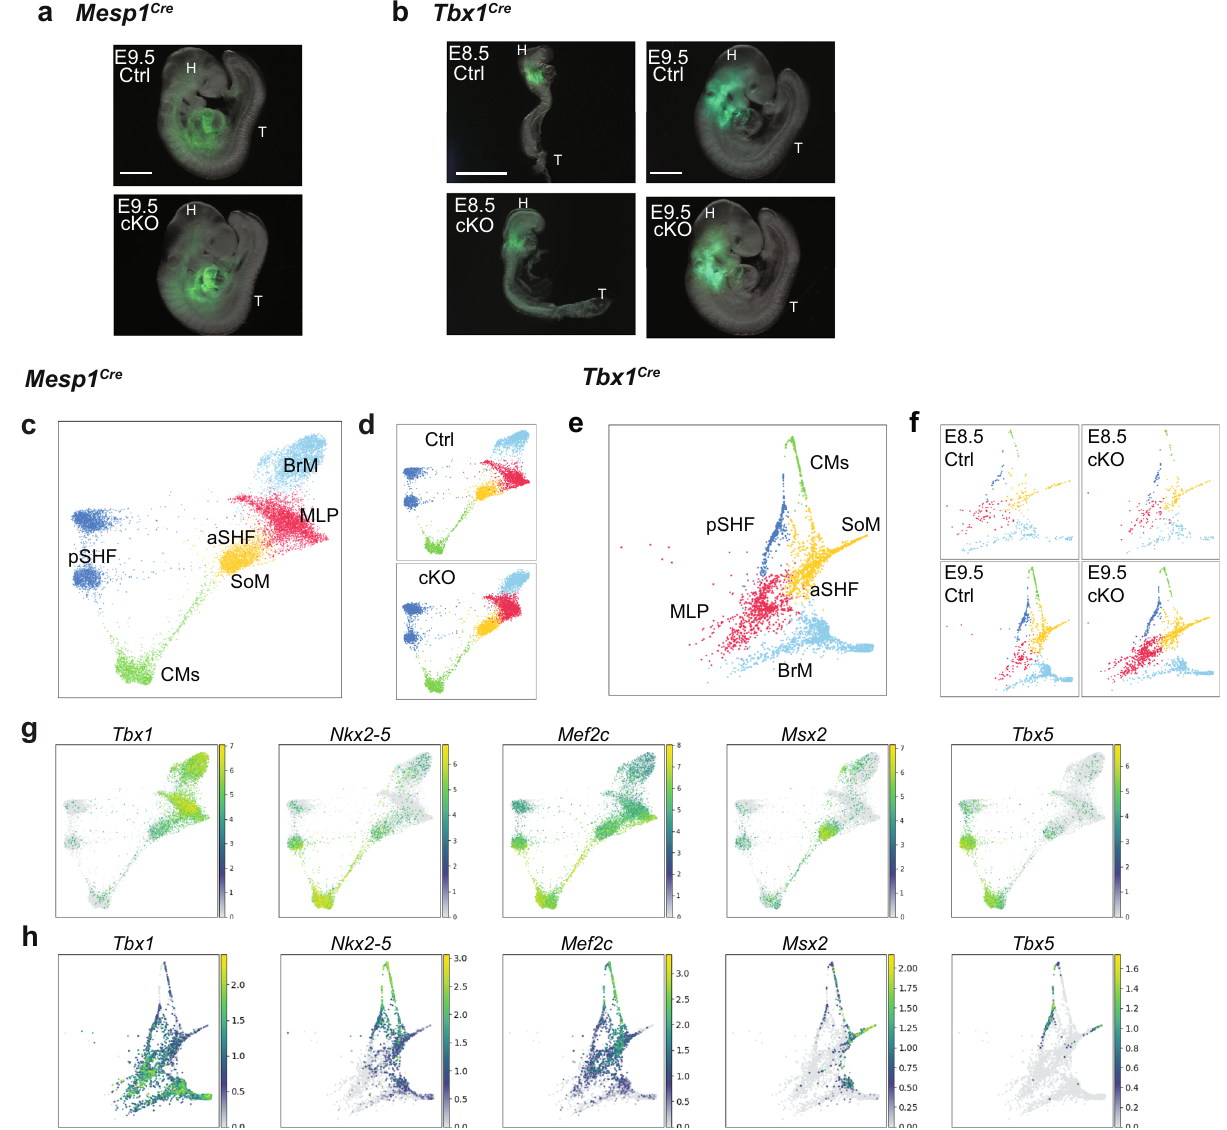
Fig. 5 Tbx1 is required for the progression of MLPs to more differentiated states. a Whole-mount embryo images with GFP fl uorescence of Mesp1 Cre ; ROSA26-GFP f/ + (Ctrl; upper panel, similar to Fig. 1a) and Mesp1 Cre ; ROSA26-GFP f/ + ;Tbx1 f/f (cKO; lower panel) embryos at E9.5 used for scRNA-seq. The pharyngeal apparatus and heart were collected. The sorted GFP-positive cells were used for scRNA-seq. H head, T tail. Scale bar, 500 µ m. b Whole-embryo images with GFP fl uorescence of Tbx1 Cre/ + ; ROSA26-GFP f/ + (Ctrl; upper panels) and Tbx1 Cre/f ; ROSA26-GFP f/ + (cKO; lower panels) embryos at E8.5 (left) and E9.5 (right) used for scRNA-seq. The upper half of the body was collected at E8.5. The pharyngeal apparatus and heart were collected at E9.5. Sorted GFP-positive cells were used for scRNA-seq. Scale bar E8.5 is 400 µ m; E9.5 is 500 µ m. c Single-cell embedding graph of the CPM populations from the integration of two replicates of Mesp1 Cre Ctrl vs cKO datasets colored by clusters. De fi nitions of clusters are the same as in Fig. 1, with the addition of SoM, somatic mesoderm. d Single-cell embedding graph separated by genotype. Upper panel, Mesp1 Cre Ctrl dataset. Lower panel; Mesp1 Cre cKO dataset. e Single-cell embedding graph of integration of CPM lineages from Tbx1 Cre Ctrl and cKO datasets at E8.5 and E9.5 colored by cell clusters. f Single-cell embedding graph separated by samples. Upper left and right, Tbx1 Cre Ctrl and Tbx1 Cre cKO dataset at E8.5. Lower left and right, Tbx1 Cre Ctrl and Tbx1 Cre cKO dataset at E9.5. g , h Single-cell embedding graph of the CPM lineages from integrated Mesp1 Cre Ctrl and cKO datasets ( g ) and Tbx1 Cre Ctrl and cKO datasets ( h ) colored by expression level (gray to blue, green, yellow, low to